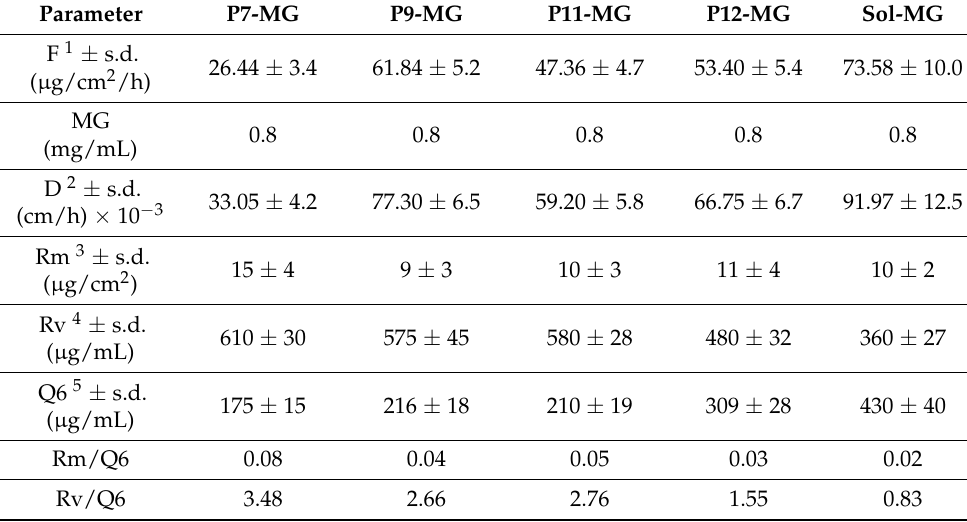
Table 5. Diffusion parameters of the indicated formulations.